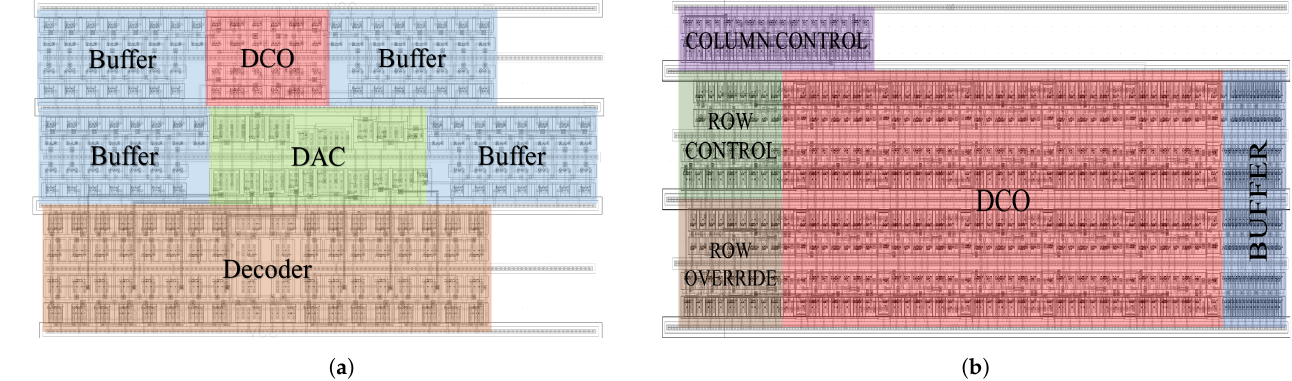
Figure 8. Layout of the ( a ) DAC-based DCO, ( b ) Controller-based DCO.